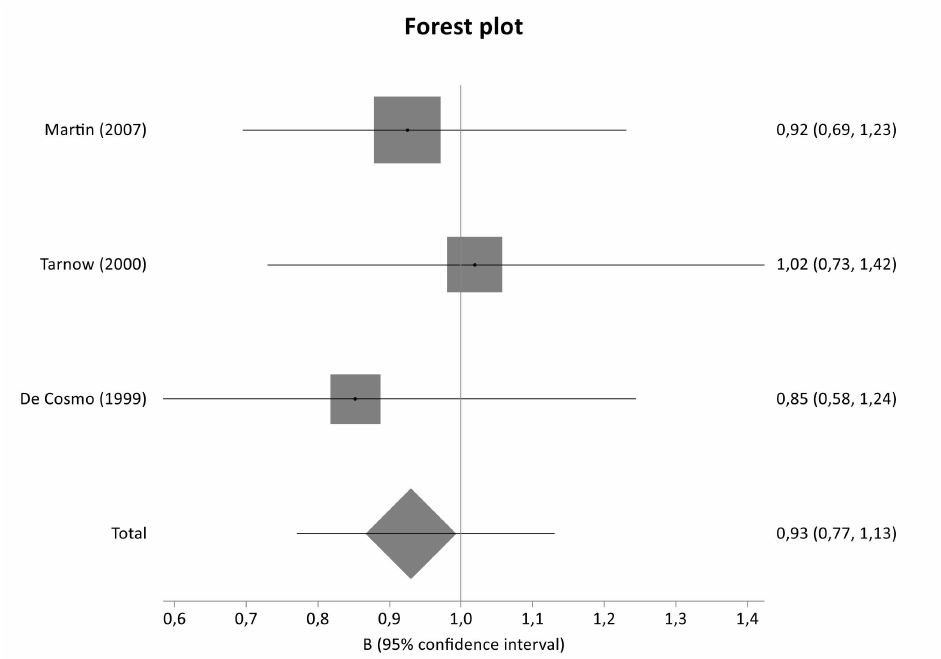
Figure 3. Forest plot of SERPINE1 4G/5G variant between diseased controls versus cases in T1DM subgroup meta-analysis.